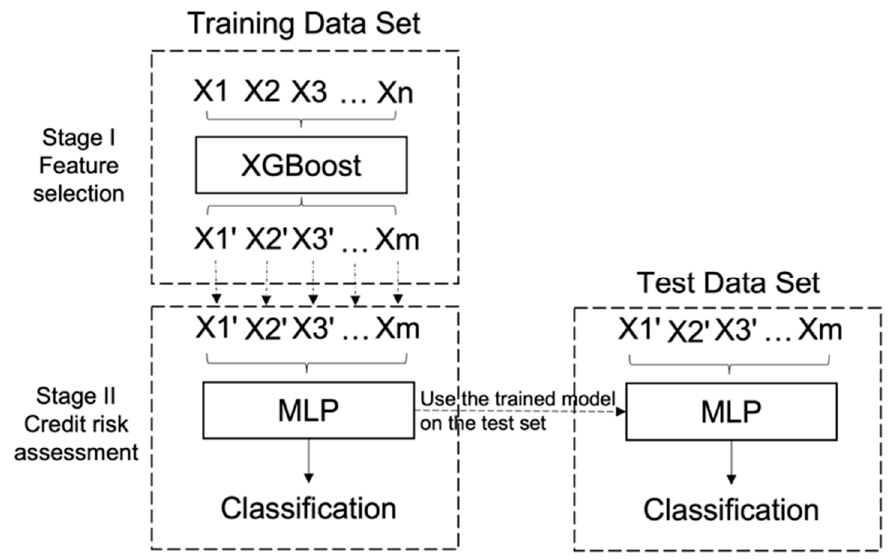
Figure 2. The flowchart of XGBoost-MLP.